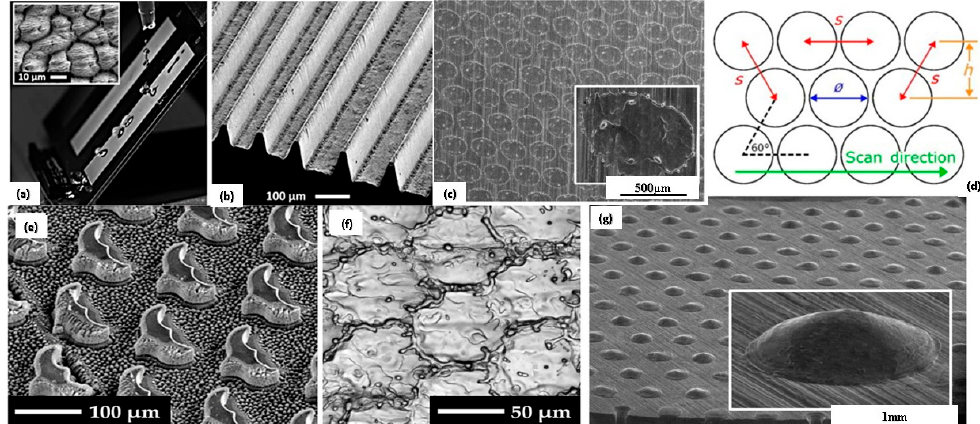
Figure 3. ( a ) Multi-scaled texturing for water-repellent surfaces by LST approach, ( b ) shark-skin- inspired structure texturing entails the reduction of skin drag friction to turbulence flow, ( c ) deep welding dots prepared by CW laser radiation, ( d ) Surface texturing by variable pulse energy and pulse overlap, ( e ) Surface texturing for enhancing boiling heat transfer, ( f ) formation of dimples for static friction enhancement, ( g ) Hemispherical surface textures formed by ns-pulsed LST [111,117,119]. Copyright Permission 2014, Elsevier. Table 2. Surface texturing formed by LIPSS approach.